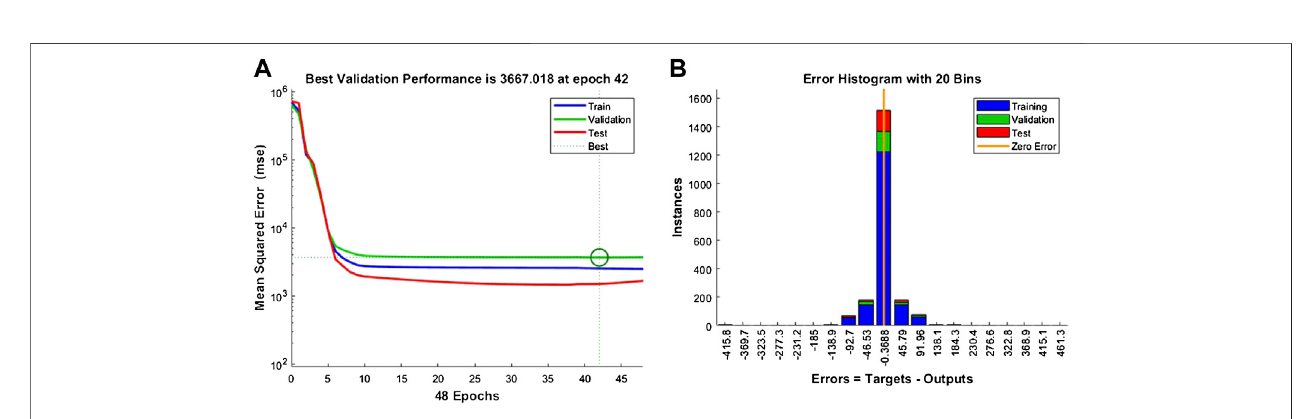
FIGURE 8 | (A) Training history and (B) error